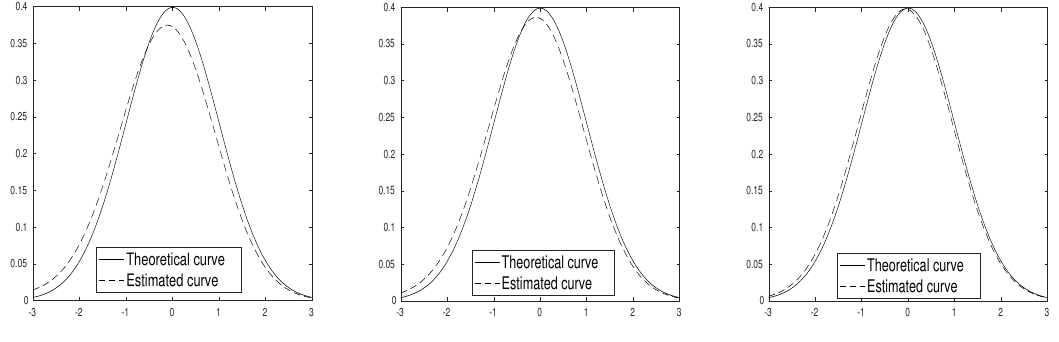
Figure 1: CR ≈ 55% and ρ = 0.3 for n = 50, 200 and 400